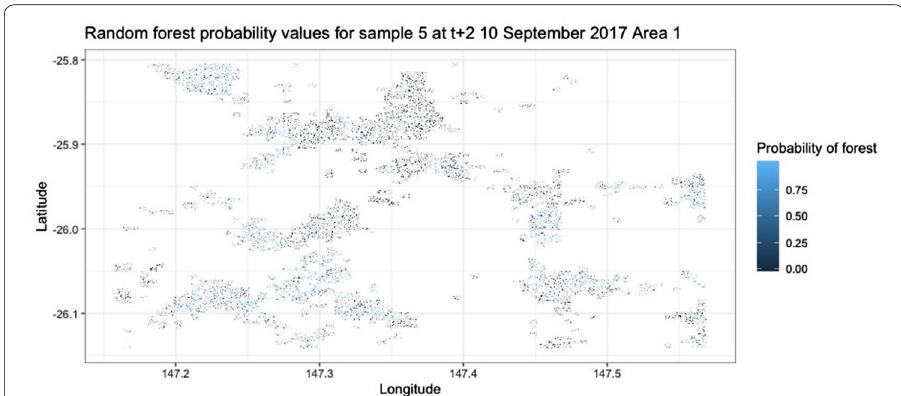
Fig. 6 Posterior probability of forest at pixel scale obtained from SS‑RF method plotted by spatial coordinates. The probability that each pixel has a land cover classification of forest is indicated by the shading; darker blue indicates low probability the pixel is forest and light blue indicates high probability of forest in that pixel. The pixels are in patches because they are part of a testing data sample that was taken at random within the clouded area of the image